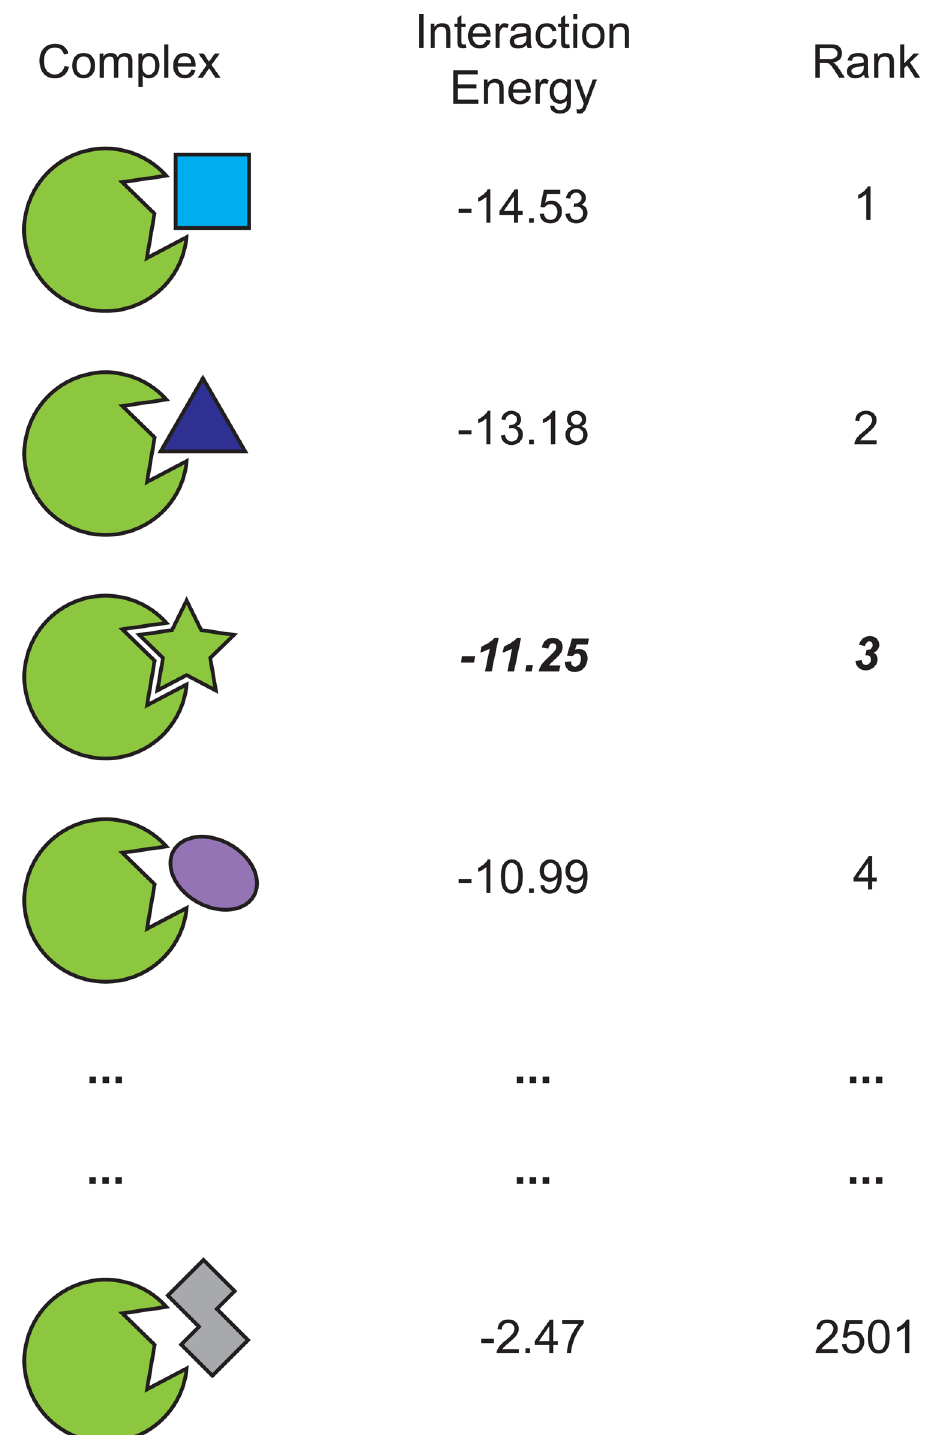
Fig 1. Overview of the virtual screening benchmark. A target protein is provided in complex with a known small-molecule inhibitor acting at this protein interaction site. A collection of 2500 diverse “ decoy ” ligands have also been docked to this site. The benchmark entails scoring each of the 2501 complexes, and determining the rank of the native ligand relative to the decoy compounds. This experiment carried out for each of 18 non-redundant protein targets (Table